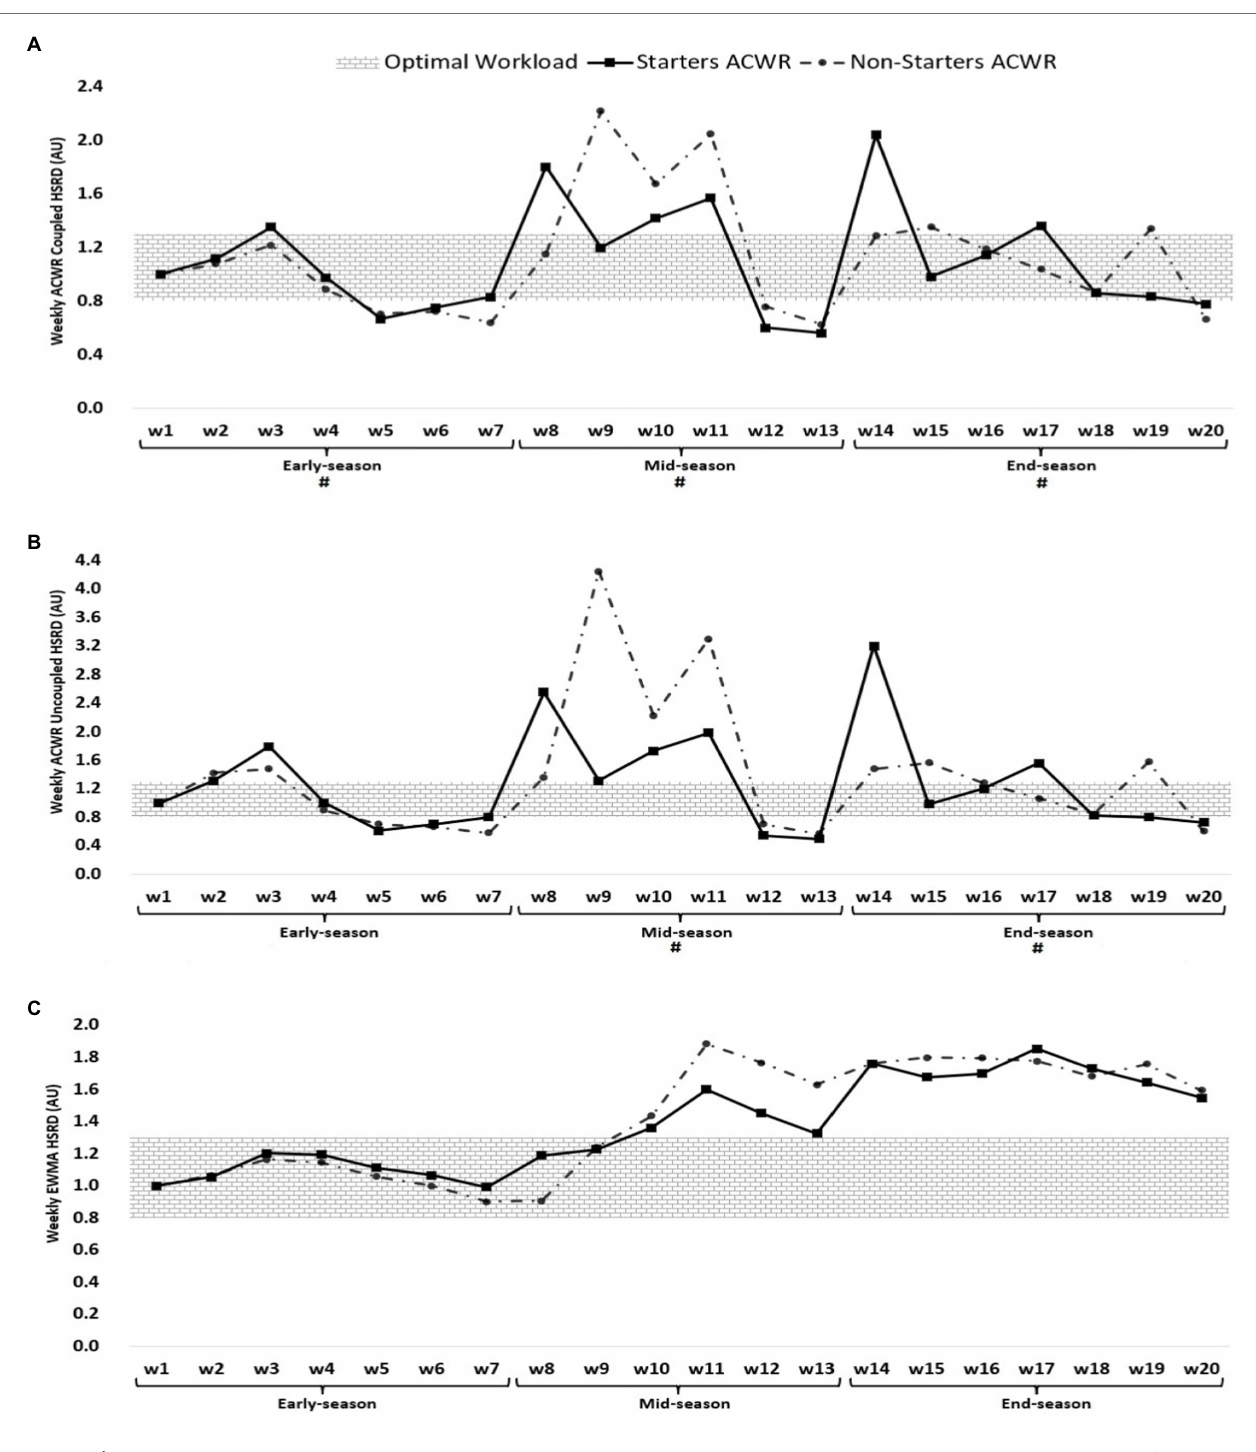
FIGURE 3 | ACWR coupled (A) and uncoupled (B) , and EWMA (C) variations calculated through the HSRD across 20-week starters and non-starters. # Denotes significant differences between starters and